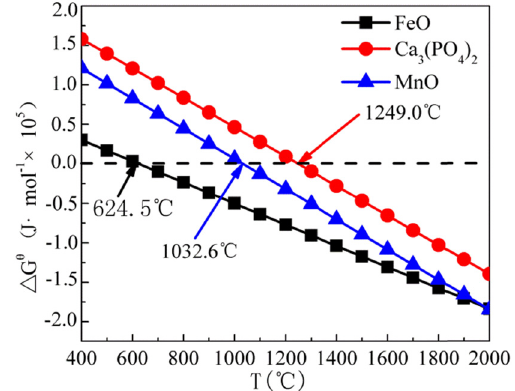
Figure 3: Relationship between standard Gibbs free energy and temperature.